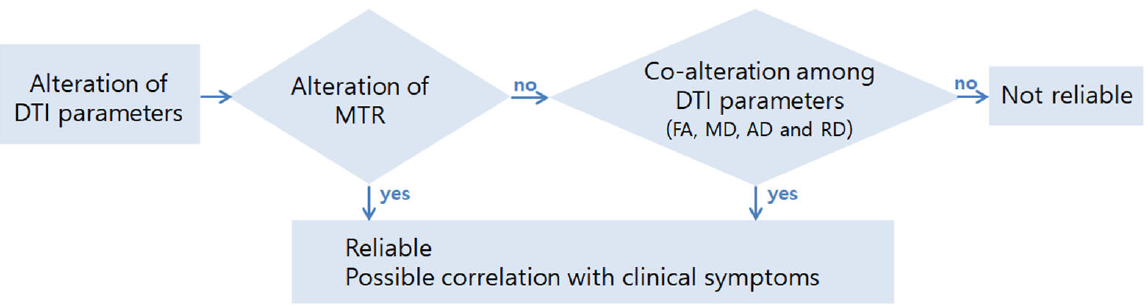
Figure 6. Schematic interpretation process of MR parameters.